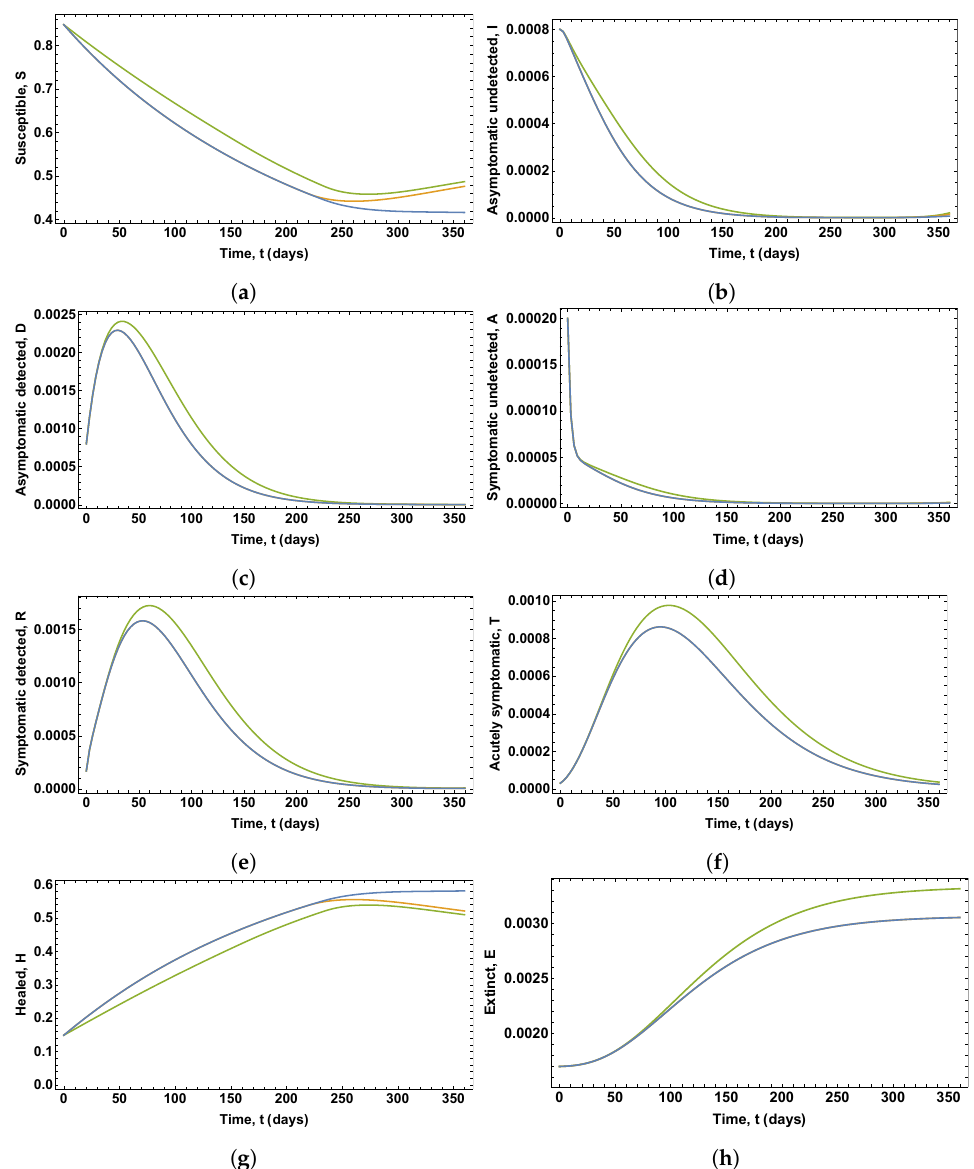
Figure 3. Proportions of people in each compartment for scenario 1 (blue), scenario 2 (orange), and scenario 3 (green): ( a ) Susceptible people. ( b ) Asymptomatic undetected people. ( c ) Asymptomatic detected people. ( d ) Symptomatic undetected people. ( e ) Symptomatic detected people. ( f ) Acutely symptomatic people. ( g ) Healed people. ( h ) Extinct